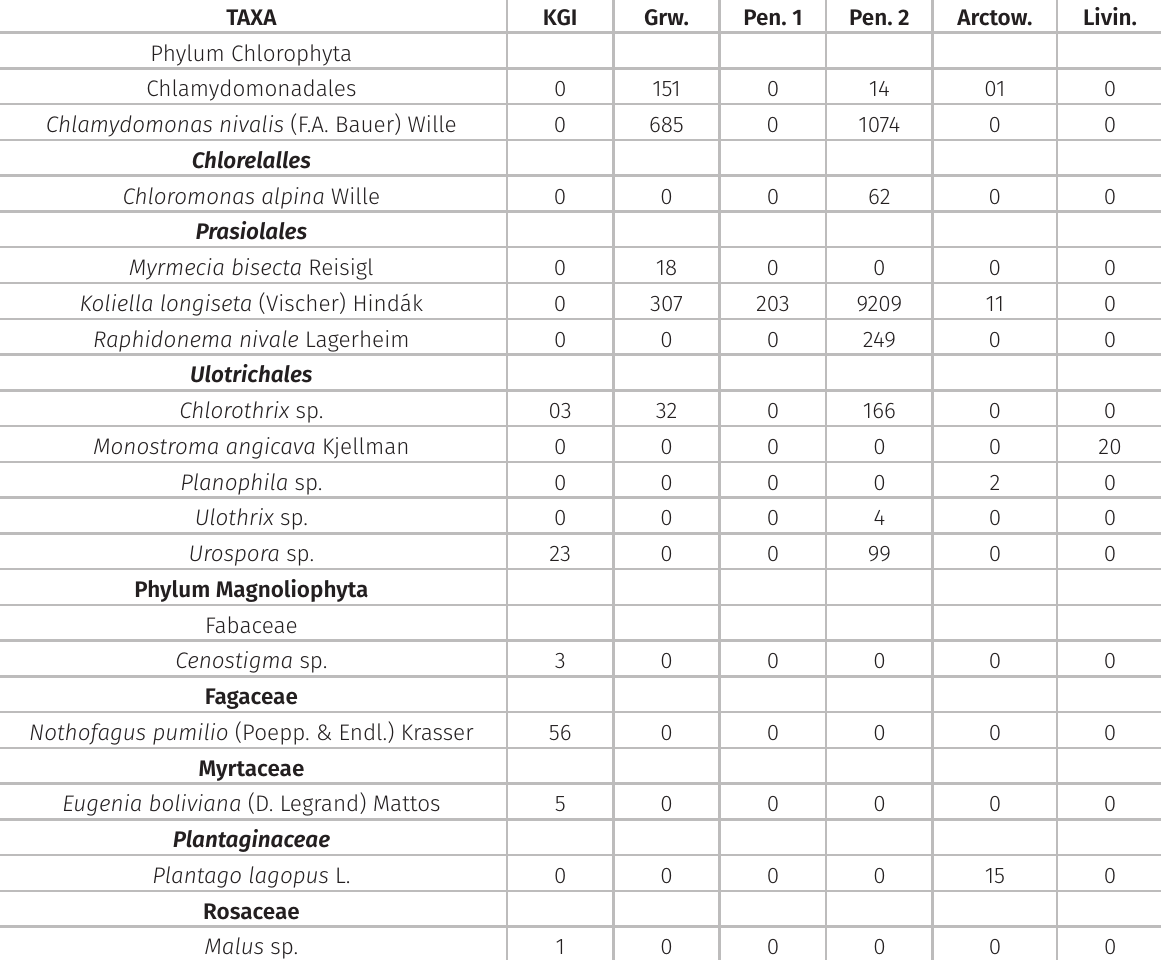
Table II. Assigned plant OTUs present in glacier ice obtained from six different sampling locations, with the number of reads for each. KGI = King George Island, Grw. = Greenwich Island, Pen1 = Antarctic Peninsula 1, Pen2= Antarctic Peninsula 2, Arctow.= Arctowski Peninsula and Living. = Livingston